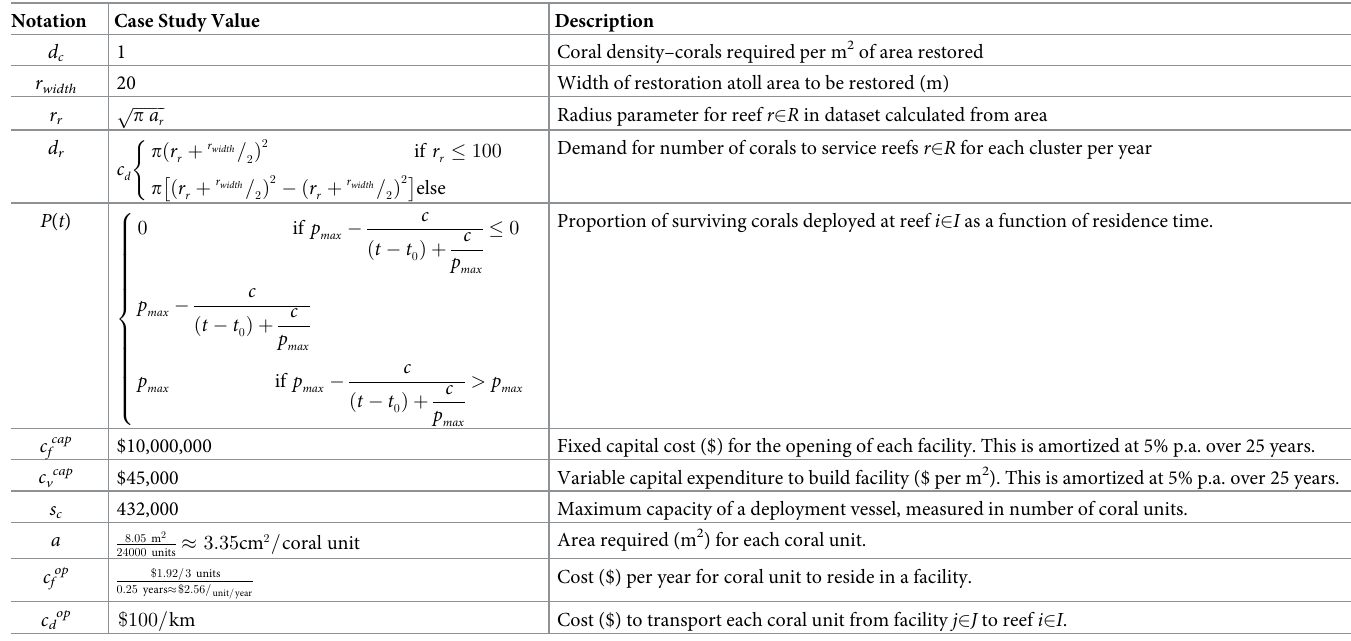
Table 1. Description of model parameters and assumed values based on expert elicitation and estimates.